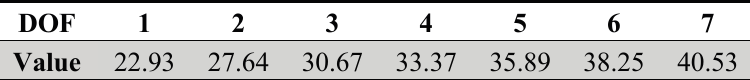
Table 2. Values of chi-square threshold (probabilities of false alarm is 10 − 4 ) for given degree of freedom